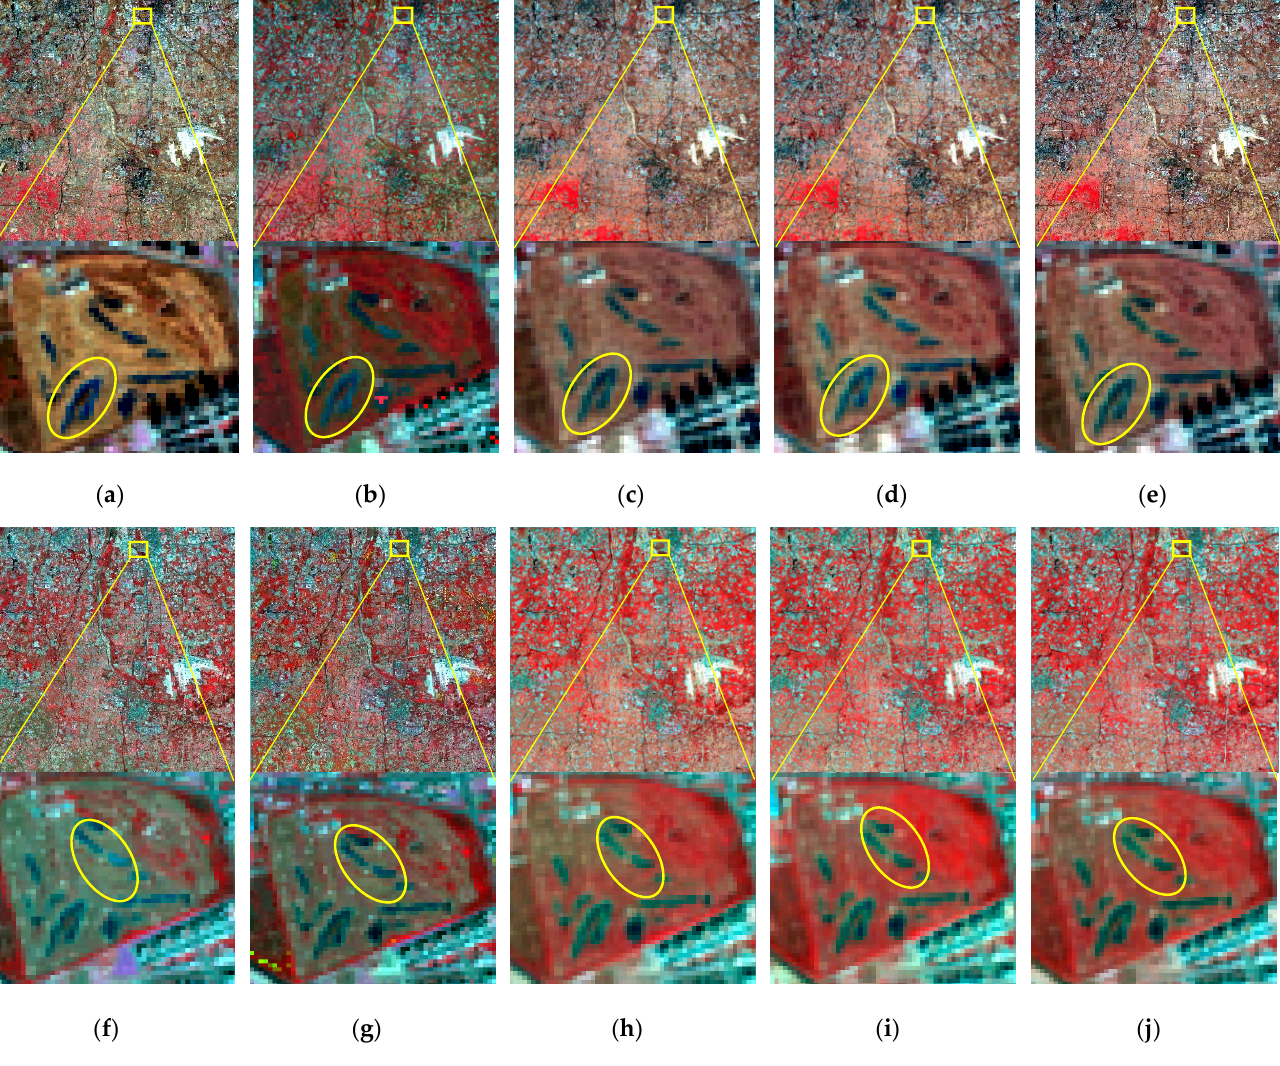
Figure 17. Experimental results based on the Daxing dataset for spatiotemporal fusion with different module structures: ( a , f ) Ground truth image; ( b , g ) EDCSTFN method results; ( c , h ) Only edge method results; ( d , i ) Edge-FA-encoder method results; and ( e , j ) Edge-FA-decoder method results.